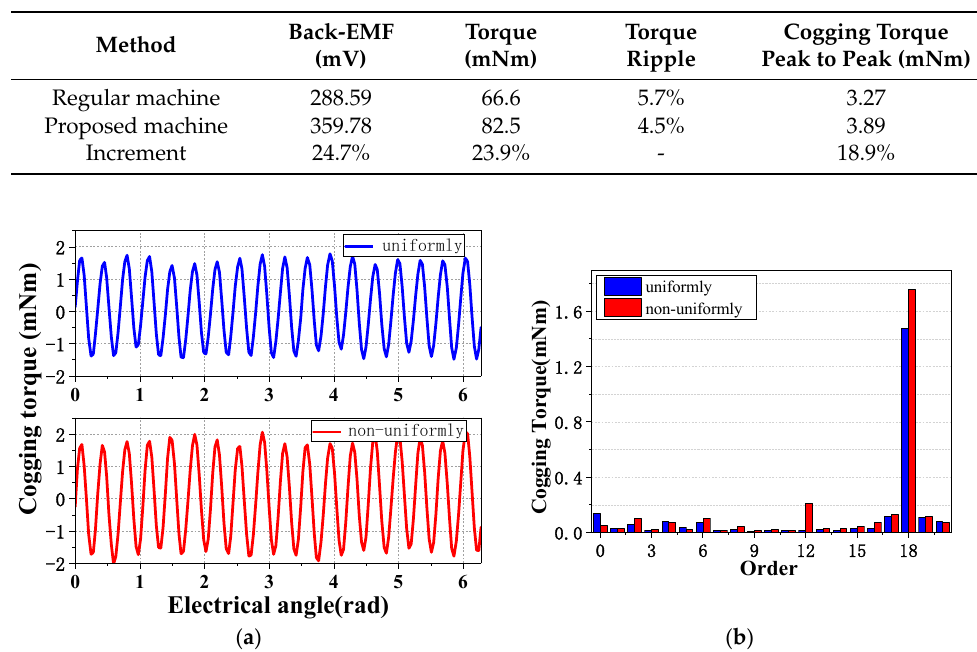
Figure 15. Comparison of performance at 50 rpm by FEM: ( a ) back-EMF; ( b ) electromagnetic torque with rated 0.4 A rms current. Table 5. Comparison of two topologies.